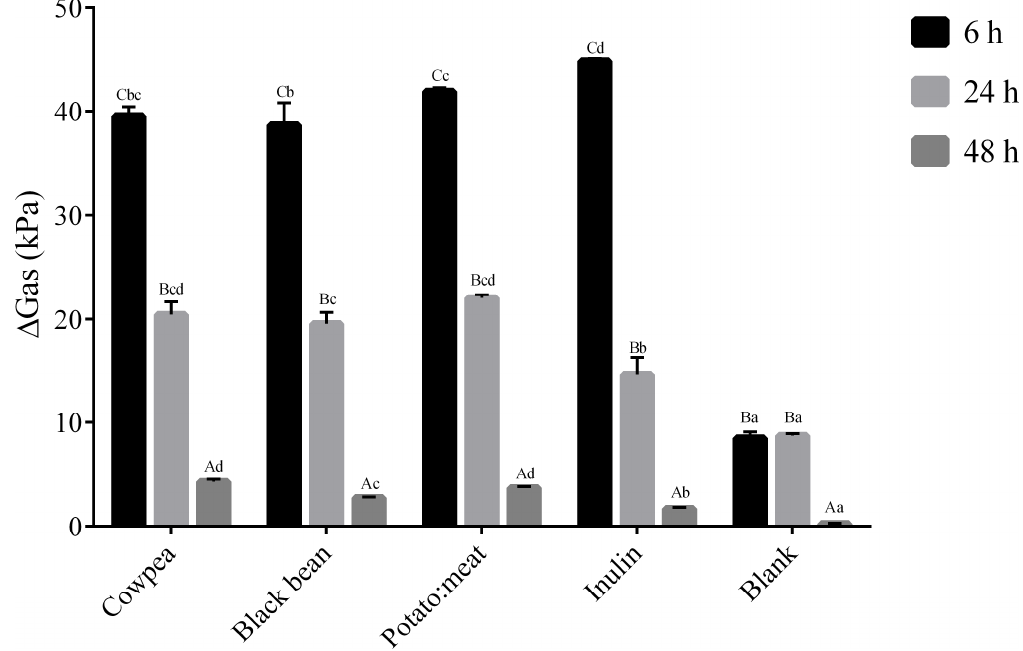
Figure 3. Gas increment during fermentation time (kPa). Results are expressed as mean and standard deviation. The data marked by the same letters were not significantly different ( p > 0.05). Different uppercase letters for comparison within each fermentable source at a different time and lowercase letter for comparison within the different fermentable source at the same time, indicating significant differences at p < 0.05.